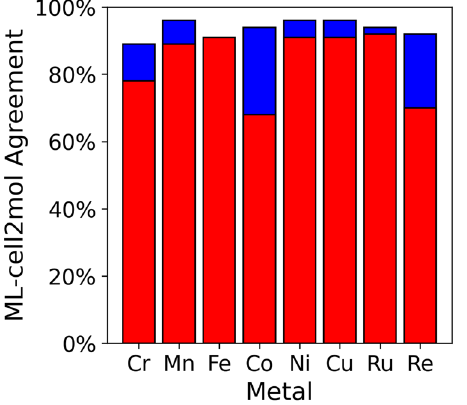
Fig. 6 Performance of the ML model for the test and prediction sets. Comparison of the performance of the trained ML model (see Methods) at predicting the metal OS. In blue, the reliability of the model, established by comparison with the.cif fi les in the test set. In red, the agreement between cell2mol and the ML model in the assignation of metal OS for the prediction